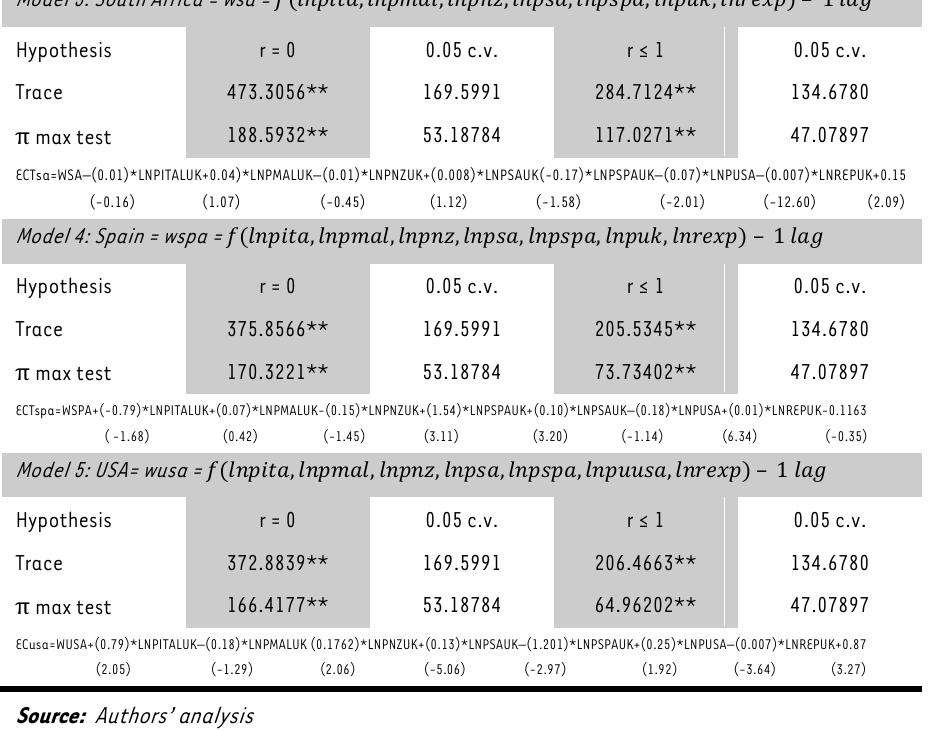
Model 3: South Africa = wsa =